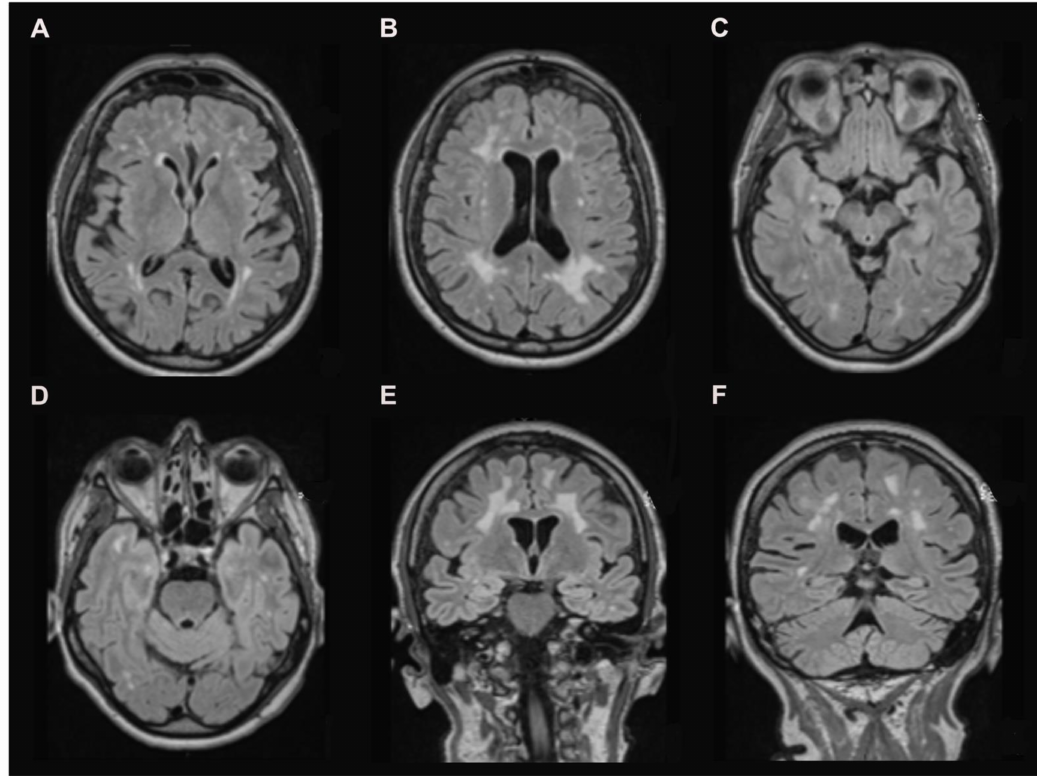
Figure 2. ( A – C ) Axial T2-weighted magnetic resonance images show a high signal intensity in patchy, confluent periventric- ular and subcortical areas of the white matter with a clear predominance in supratentorial areas. The basal ganglia and brainstem did not show any abnormalities. ( D ) Axial T2-weighted magnetic resonance images and ( E ) coronal T2-weighted magnetic resonance images show a slight temporal lobe involvement. ( F ) Coronal T2-weighted magnetic resonance images show no cerebellar abnormalities.